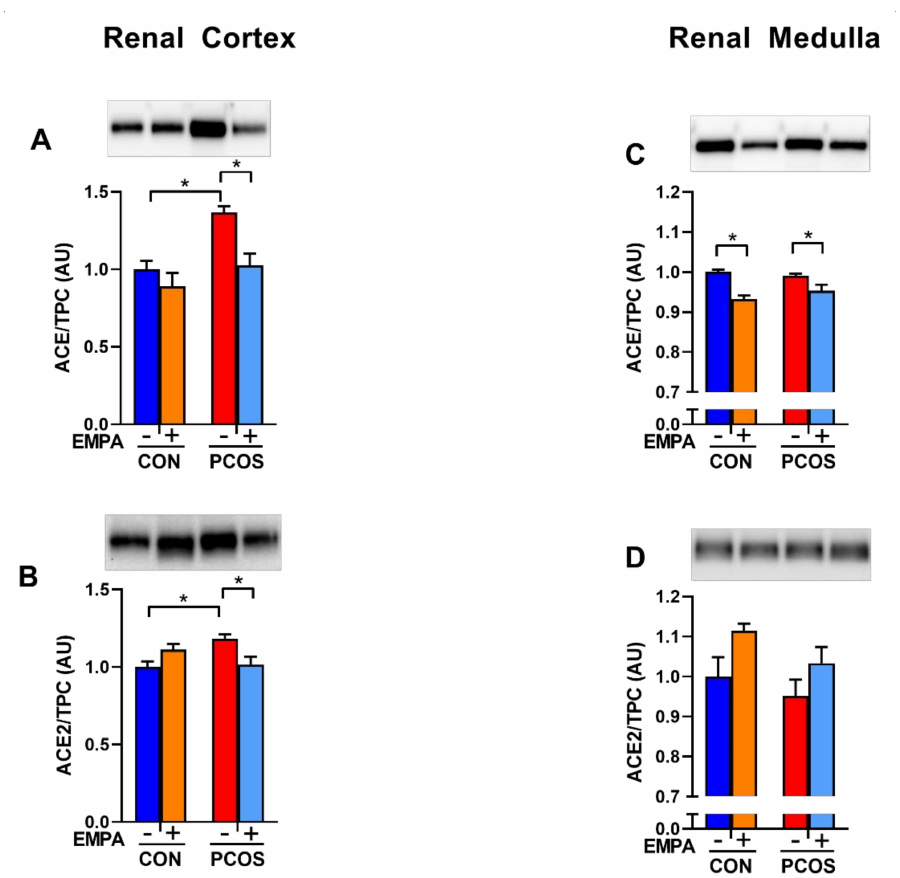
Figure 7. Effect of EMPA on renal ACE and ACE2 protein expression in PCOS. Effect of EMPA on renal ( A ) cortical Angiotensin-Converting Enzyme (ACE), ( B ) cortical angiotensin-converting enzyme 2 (ACE2), ( C ) medullar ACE, and ( D ) medullar ACE2 protein expression after 3 weeks of EMPA treatment. Data normalized by total protein content (TPC). Data are expressed as mean ± SEM. Corresponding stain free images TPC quantification in Supplementary Figure S1. Data were analyzed by two-way ANOVA followed by Tukey post-hoc tests to avoid comparing between gels. Significant interaction was observed only for cortical ACE2. * p < 0.05. n = 3–5 per